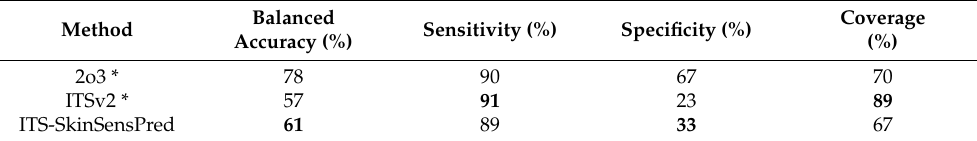
Table 3. Performance of ITS methods for classifying mixtures consisting of agrochemicals. Balanced Method Accuracy